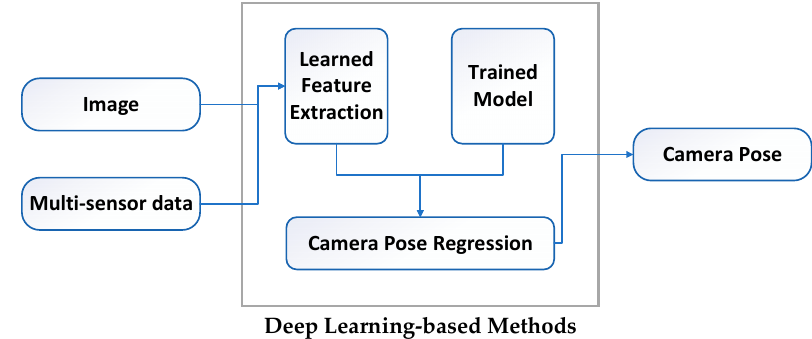
Figure 3. Pipeline of deep learning-based methods.